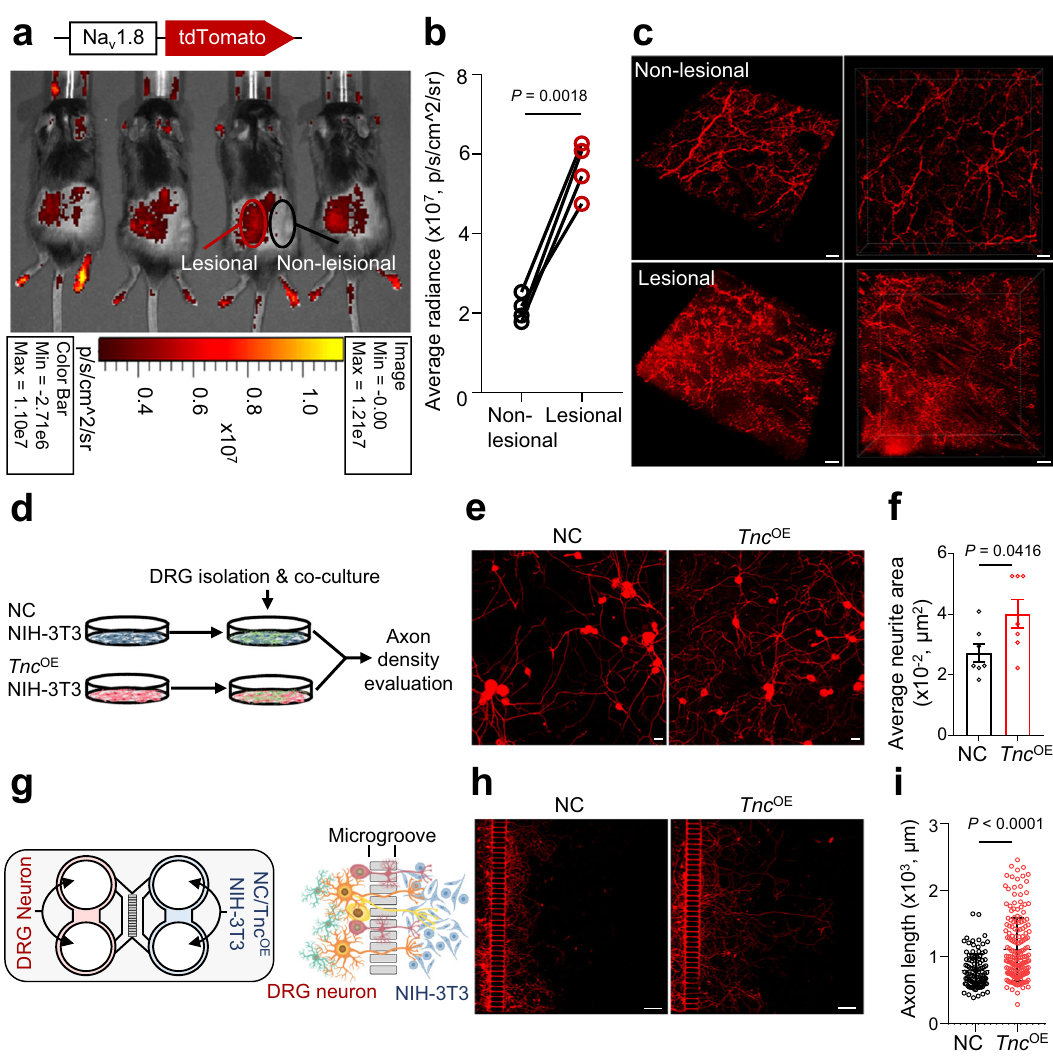
Fig. 4 | TNC promotes aberrant neurite outgrowth. Luminescence imaging ( a ) and quanti fi cation ( b ) of tdTomato + cutaneous nerves in self-control IMQ- induced Na v 1.8-tdTomato reporter mice ( n =4). c Representative whole-mount images of non-lesional or lesional skin in self-control IMQ-induced Na v 1.8-tdTo- mato reporter mice ( n =4). Scale bar, 50 μ m. d Schematic diagram of dorsal root ganglion (DRG) neuron and NC/ Tnc OE NIH-3T3 cell direct co-culture assay. NC negative control. Tnc OE , Tnc -overexpressing. Representative immuno fl uorescent images ( e ) and quanti fi cation ( f ) of average neurite area per cell (stained for β III tubulin,red) in the DRGneuronand NC/ Tnc OE NIH-3T3celldirectco-culturedishes